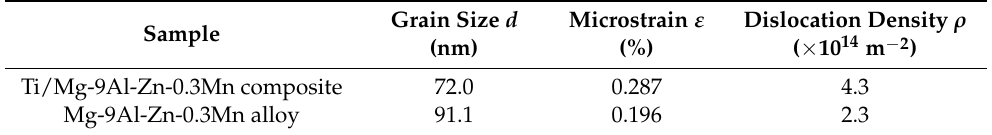
Grain Size d Microstrain ε Dislocation Density ρ (nm) (%) ( × 10 14 m − 2 )